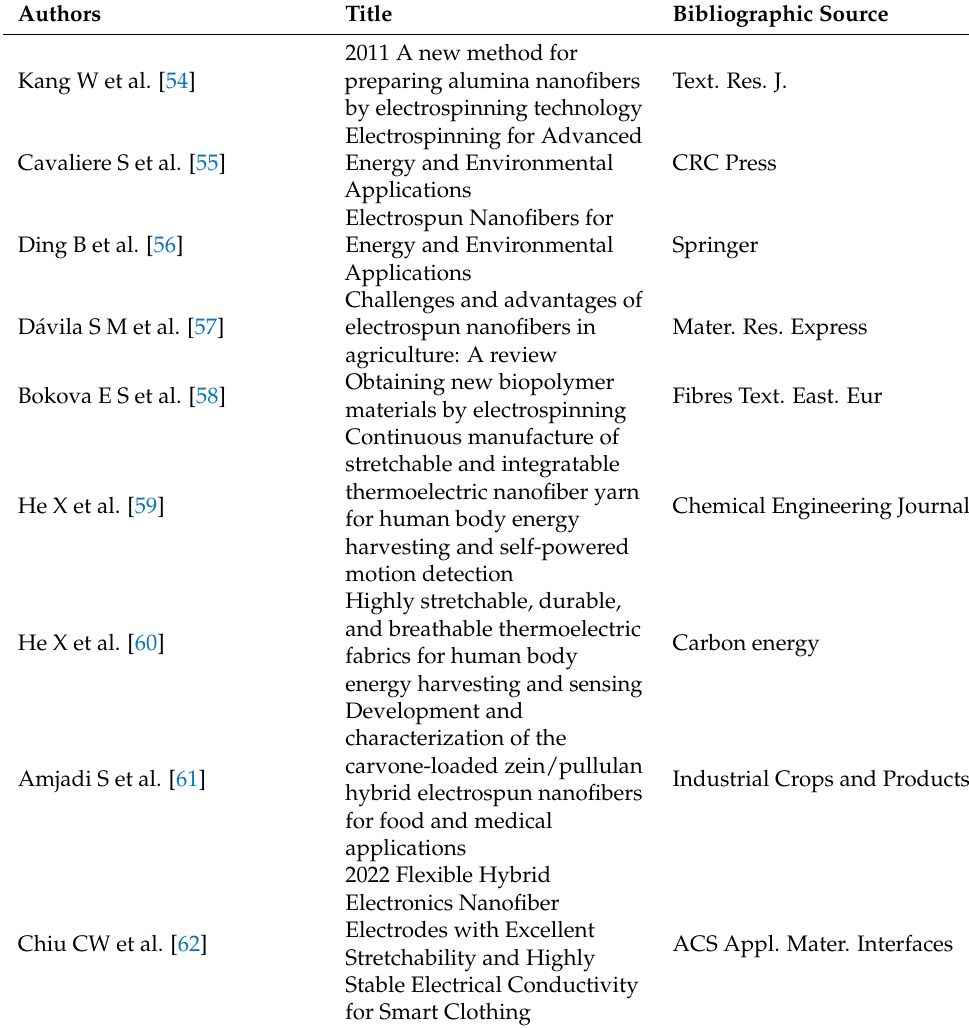
Table 3. Systematization/enumeration of electrospinning papers with bibliographic